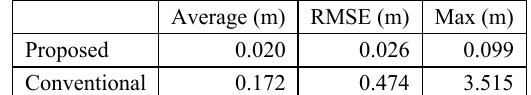
Figure 15 . An example of connected trees in an object The overall precision was 100% over the evaluation area, and recall was 95.1%, indicating very high extraction performance.